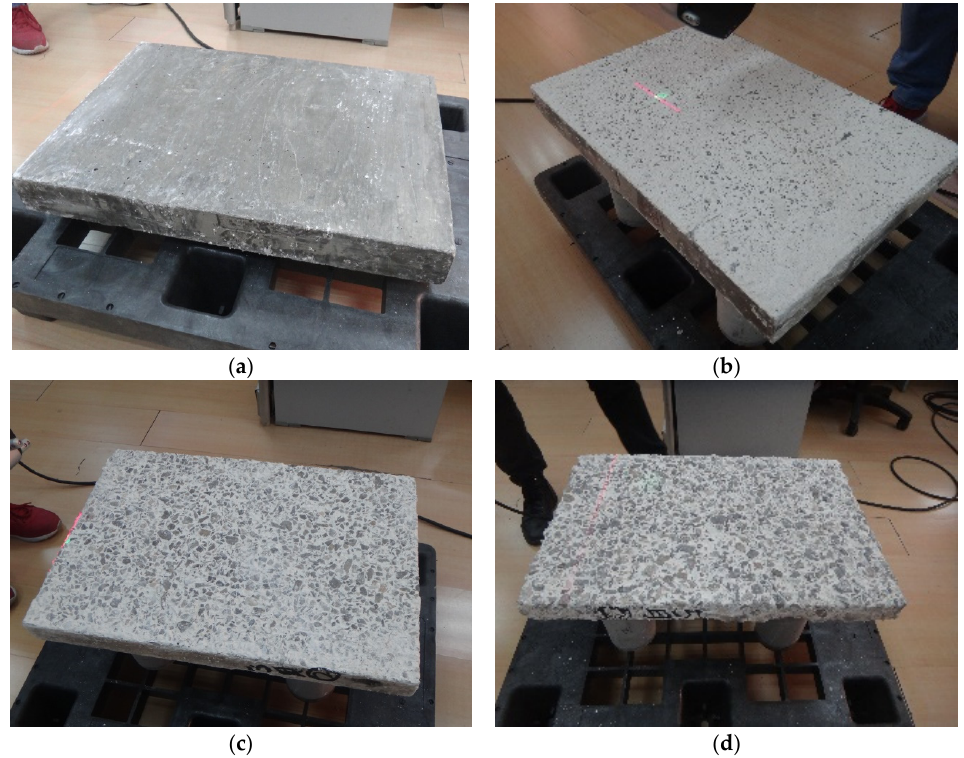
Figure 7. Photos of concrete plates eroded for 0, 31, 93, and 154 days. ( a ) Concrete plate eroded for 0 days (uncorroded); ( b ) Concrete plate eroded for 31 days; ( c ) Concrete plate eroded for 93 days; ( d ) Concrete plate eroded for 154 days.